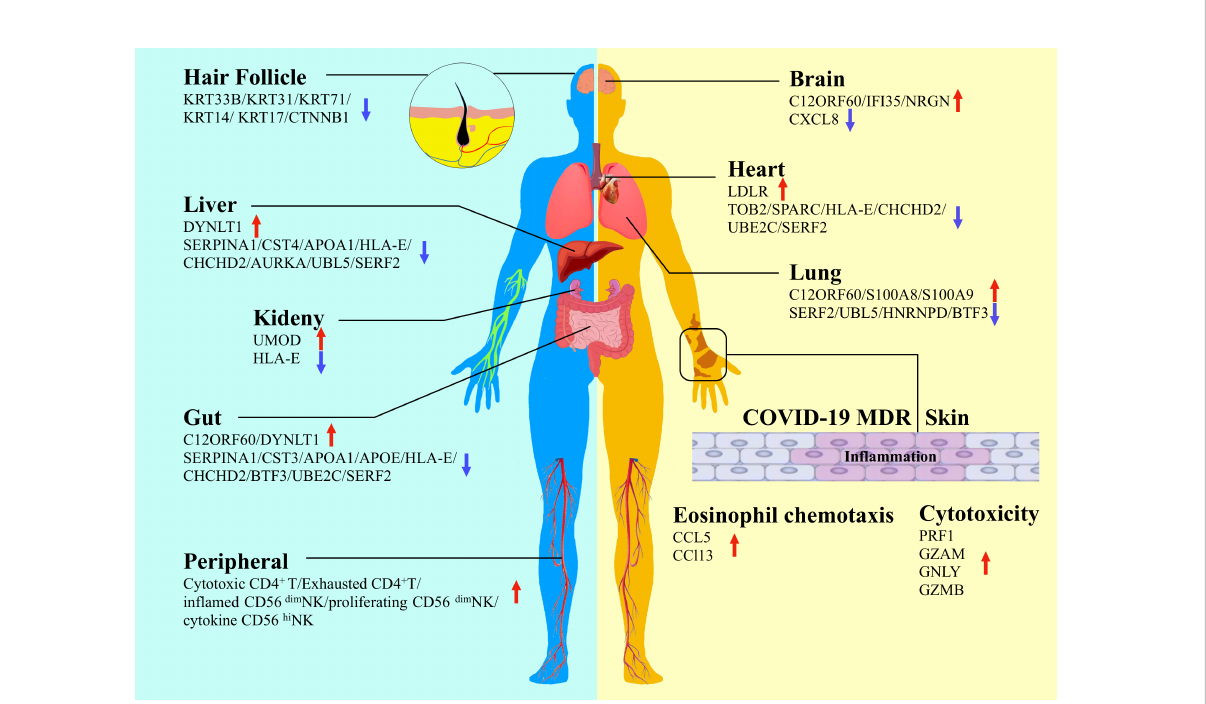
FIGURE 1 Proteomics study detects variations of protein expression in different organs infected by SARS-CoV-2 (Hair follicle, brain, heart, lung, liver, kidney, gut, skin and peripheral are shown in